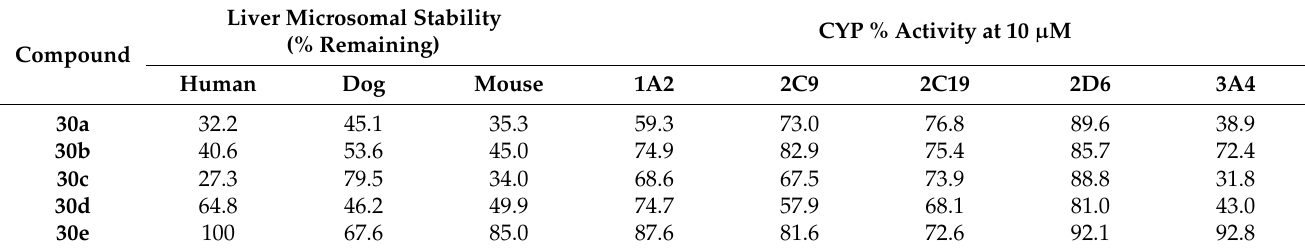
Table 6. In vitro liver metabolic stability and activity against CYPs of potent